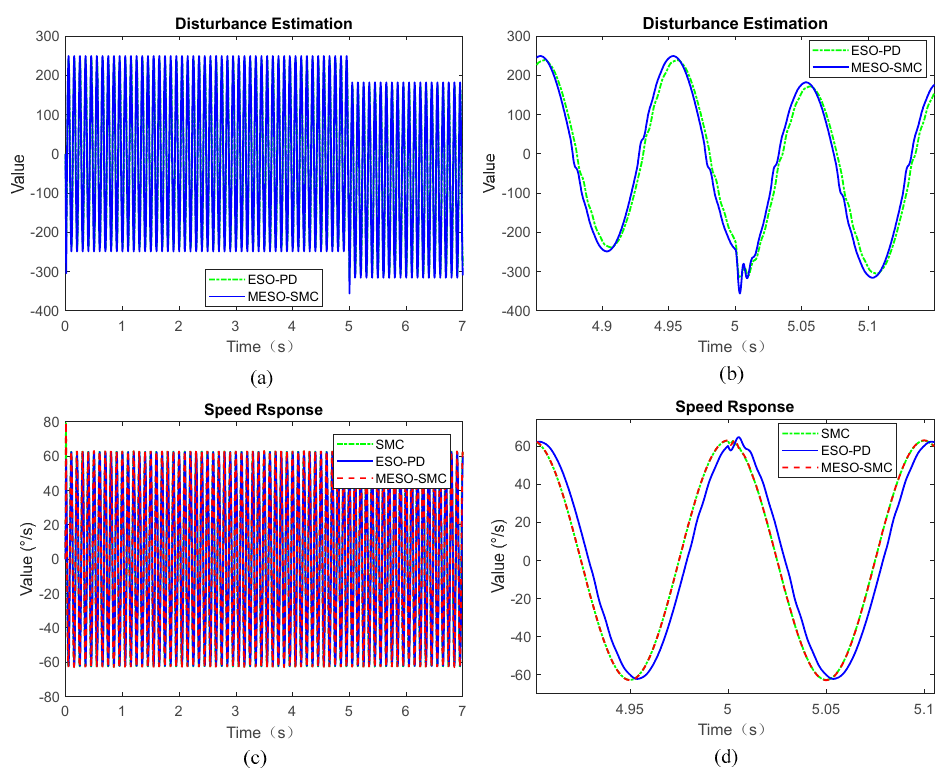
Figure 16. Disturbance estimation and velocity response. ( a ) Disturbance estimation curves. ( b ) Local curves of ( a ). ( c ) Velocity response curves. ( d ) Local curves of ( c ).